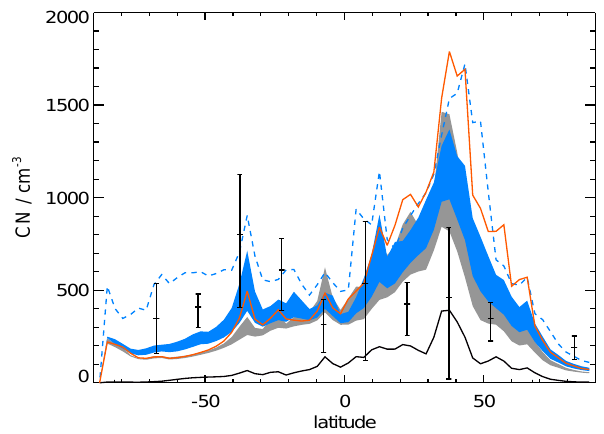
Fig. 8. Annual mean surface CN concentrations over the global oceans versus latitude. Observations (vertical bars) have been com- piled from several field campaigns (Heintzenberg et al., 2000) and show mean concentrations ± one standard deviation. The model experiments are described in Table 1: Black line shows the model with primary particulate emissions only (PRI), bottom of grey shad- ing shows model with primary emissions and BHN (BHN), top of grey shading shows model with BHN and increased EC/OC num- ber emission (PRICAR). Red line shows model with BHN and in- creased primary sulfate number emission (PRISUL). Blue shad- ing shows model with primary emissions, BHN and activation BL particle formation, with the width of shading showing sensitivity to varying nucleation coefficients from A = 2 × 10 − 7 s − 1 (ACT1) to A = 2 × 10 − 5 s − 1 (ACT3). All model experiments are for CN ( > 12nm) except the blue dashed line which shows CN ( > 3nm) for the ACT2